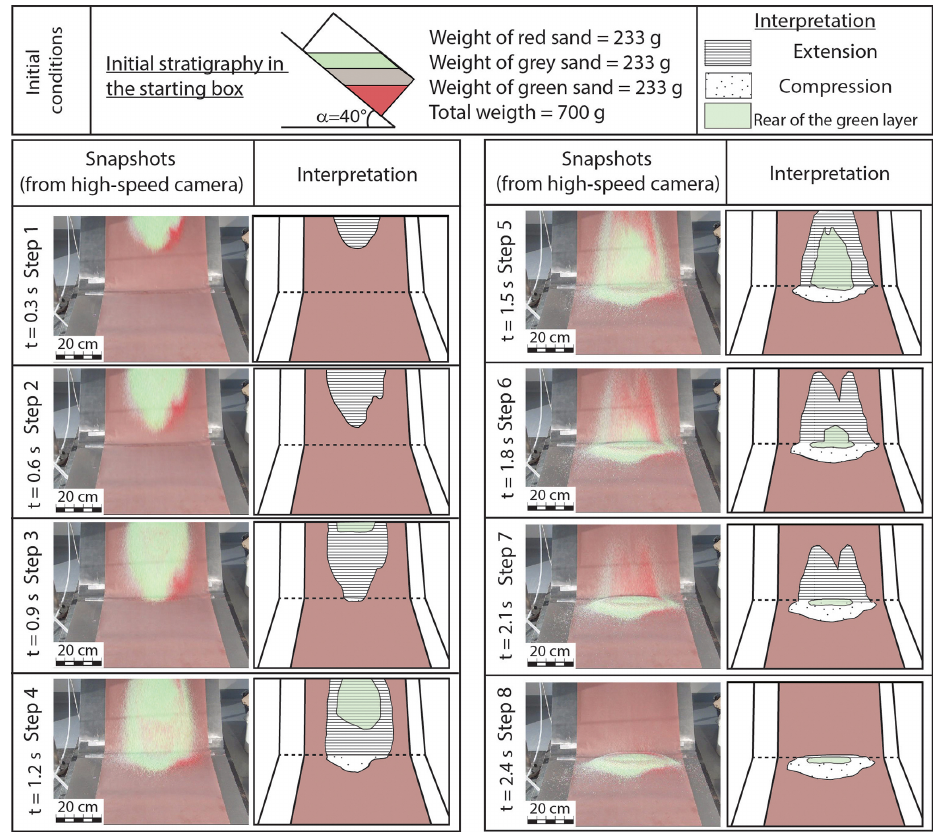
Figure 10. Time lapse of an analog granular flow (0.3s between each picture). Three colored sands were used during this experiment (red, grey, green). In the left column are the snapshots of the experiment, and in the right column the interpretation of the flowing